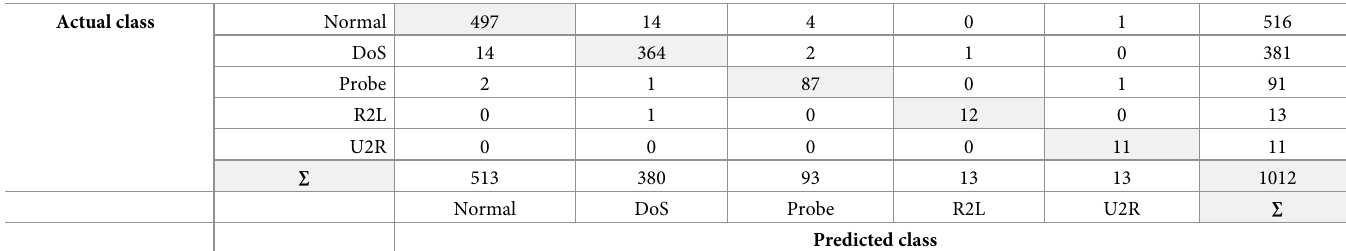
Table 5. Confusion matrix of NSL-KDD